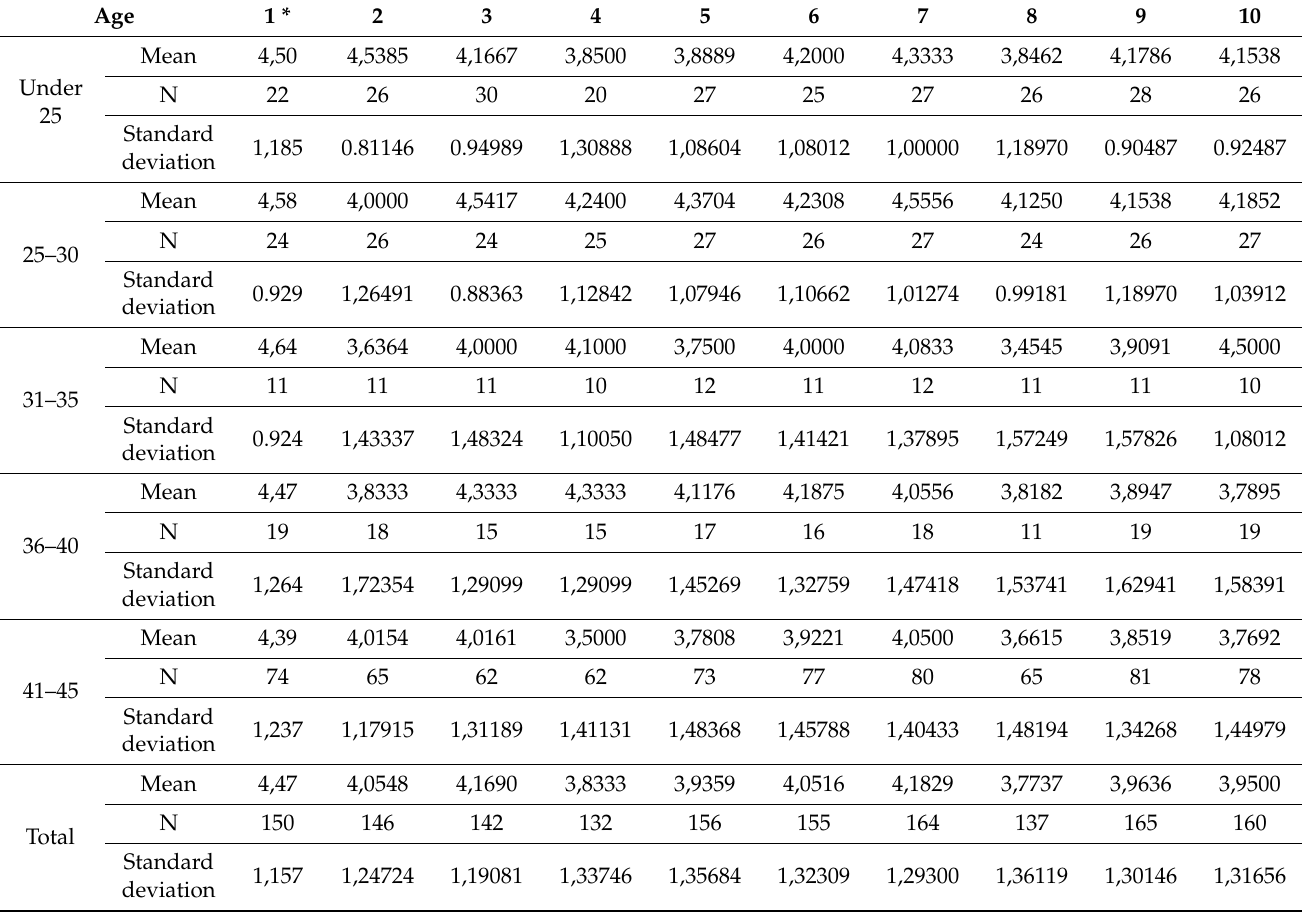
Table 4. Preference for a particular type of onboarding among respondents at a given age range.